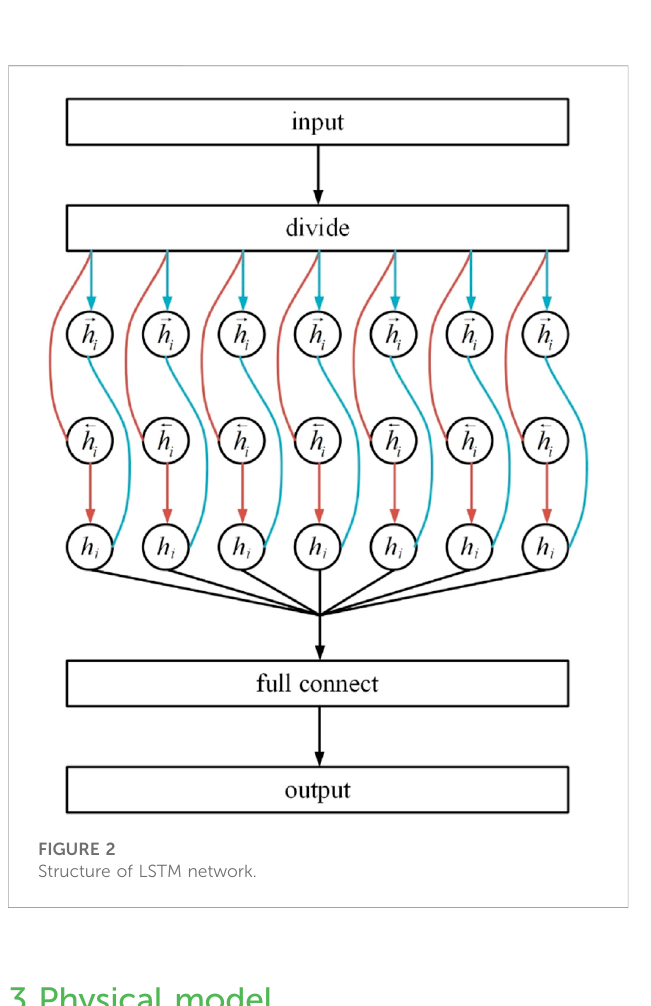
FIGURE 2 Structure of LSTM network.